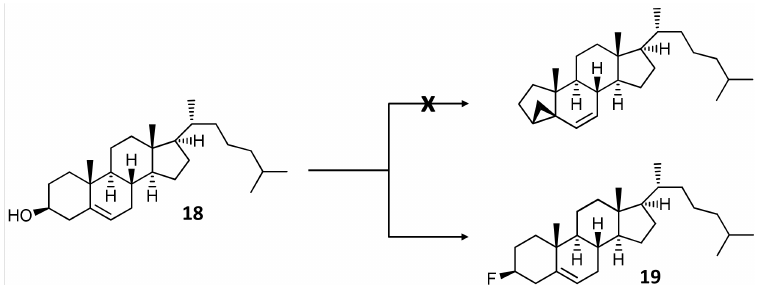
Figure 5. DAST-mediated fluorination of cholesterol ( 18 ). Reagents and conditions: DAST, anh. CH 2 Cl 2 , − 84 ◦ C → room temperature, 70